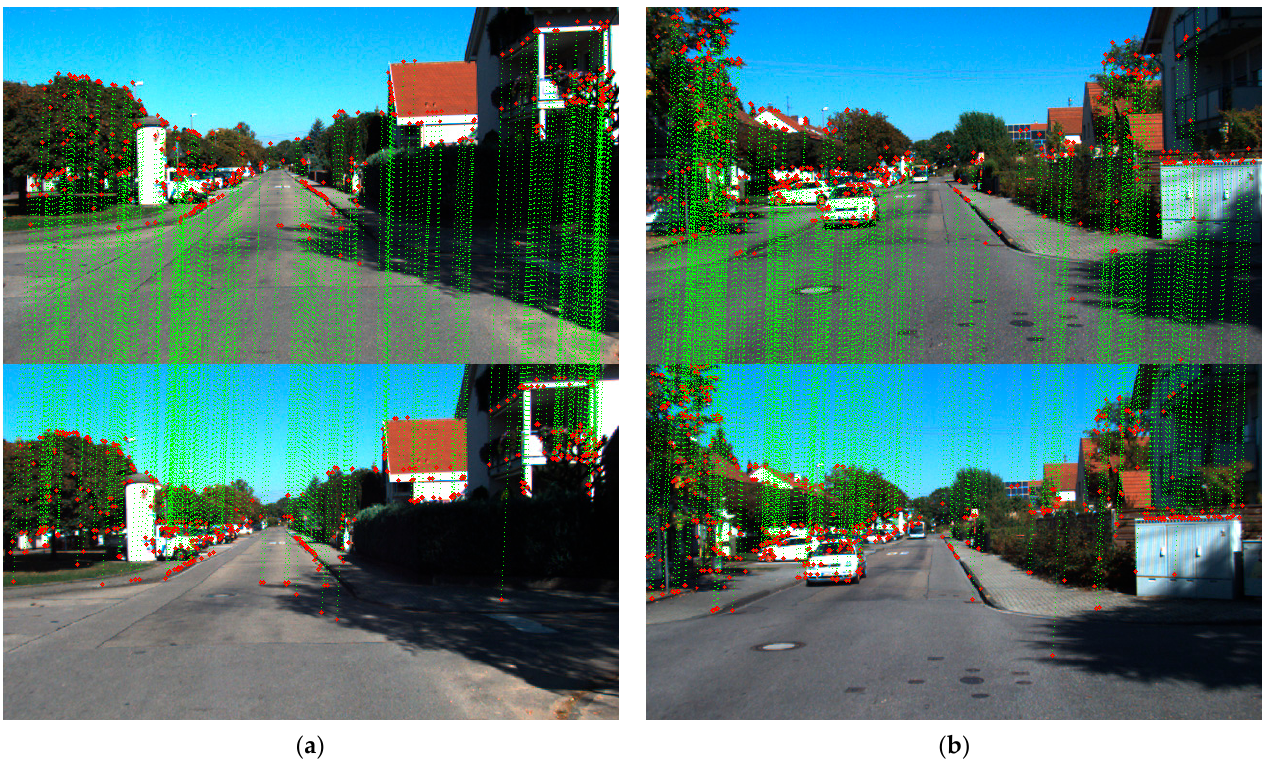
Figure 27. The same stereo visions as ( a ) Figure 26a, and ( b ) Figure 26b are aligned vertically to verify the accuracy. There is no apparent skewed matching line existed in the images.